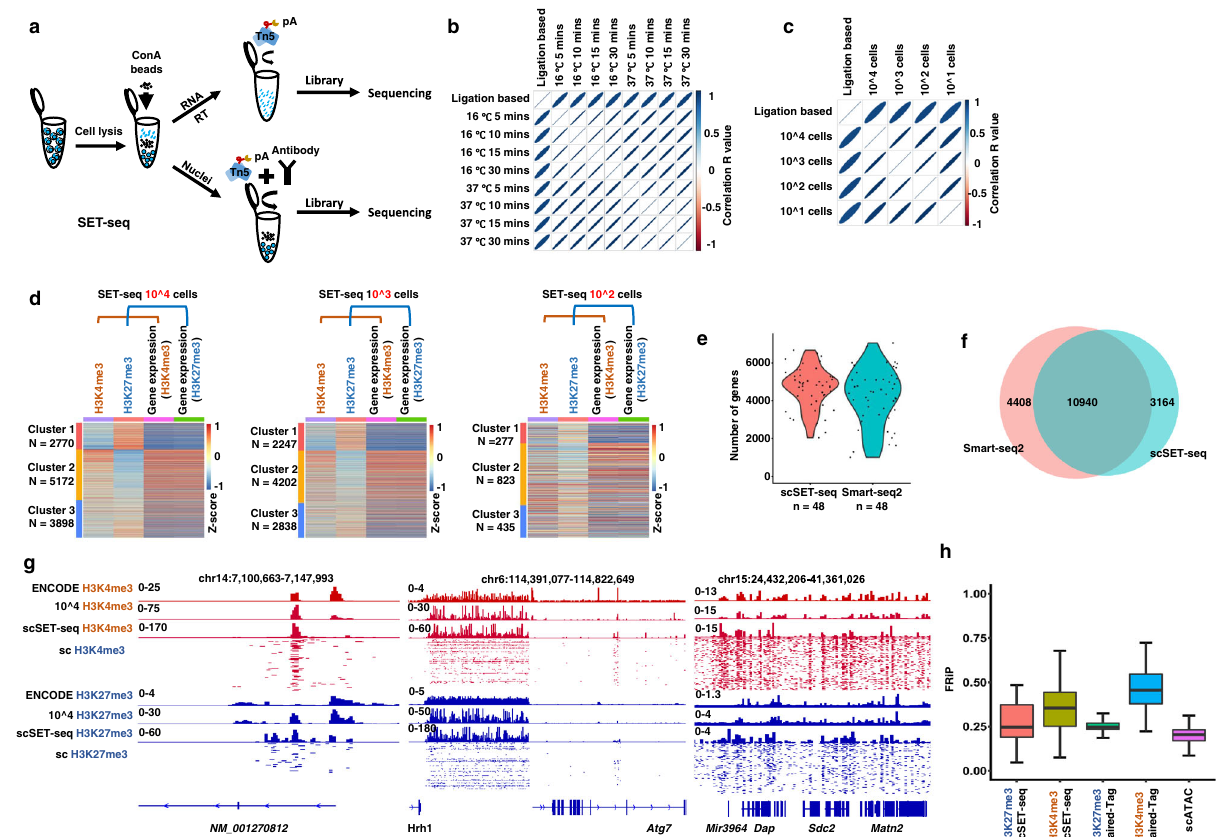
Fig. 1 SET-seq can be used to pro fi le epigenome and transcriptome in the same sample. a Schema showing the process of SET-seq. b The Pearson correlations among gene expression libraries constructed from different tagmentation time and temperatures. c The Pearson correlations among gene expression libraries constructed from different numbers of cells. d Heatmaps showing the clustering results of H3K27me3 and H3K4me3 SET-seq. Genes, at which the epigenomic and transcriptional signals were detected, were clustered by hierarchical clustering algorithms using row scaled signal scores. Heatmaps were plotted with column scaled signal scores. e Number of detected genes in scSET-seq and Smart-seq2 in 48 mESCs. Smart-seq2 data were downloaded from GSE151334 [https://www.encodeproject.org/experiments/ENCSR059MBO/] and 48 cells were randomly selected. f Venn diagram showing the overall detected genes between scSET-seq and Smart-seq2 in 48 mESCs. Smart-seq2 data were as in e . g Examples of IGV views of H3K27me3 and H3K4me3 scSET-seq. Signals of histone marks from 200 individual single cells were shown below the signals from aggregated 480 cells. H3K4me3 and H3K27me3 SET-seq results from 10,000 cells (10^4 H3K4me3 and 10^4 H3K27me3) were shown as controls. h The fraction of reads in peaks (FRiPs) of scATAC-seq and scSET-seq. scATAC-seq data were downloaded from GSE100033 [https://www.ncbi.nlm.nih.gov/geo/query/acc.cgi? acc = GSE151334]. scSET-seq cells were fi ltered with a mapping ratio >10%. Paired-Tag and 10x genomics data was same as previous reported 43 . The boxes were drawn from lower quartile (Q1) to upper quartile (Q3) with the middle line denoting the median, and whiskers with maximum 1.5 IQR (interquartile range). n = 45 (H3K27me3 scSET-seq), 200 (H3K4me3 scSET-seq), 447 (H3K27me3 Paired-Tag), 1,659 (H3K4me3 Paired-Tag), and 93 (scATAC-seq) cells. Source data are provided as a Source Data fi